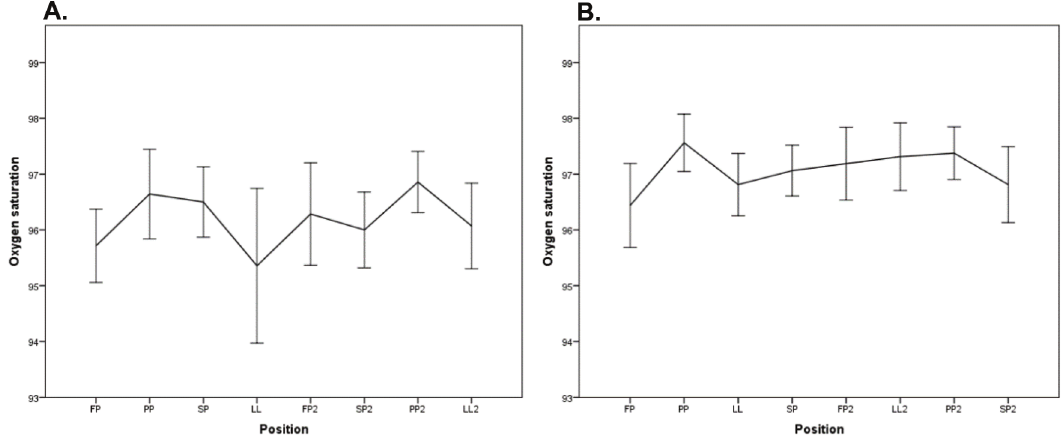
Figure 6 - Graphical representation of the oxygen saturation of the pregnant women who performed sequence 1 (A) and sequence 2